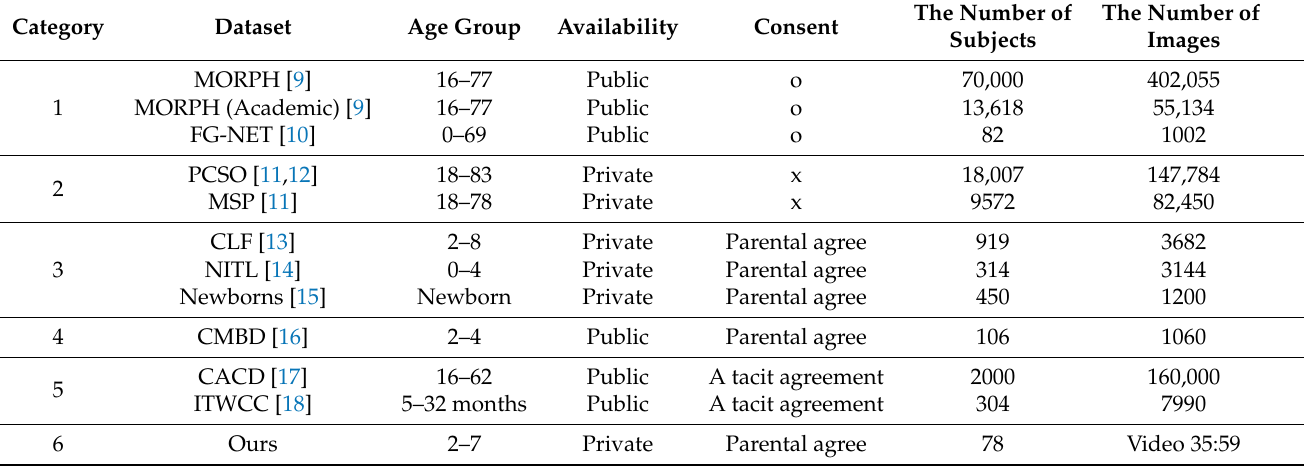
Table 1. List of children’s faces